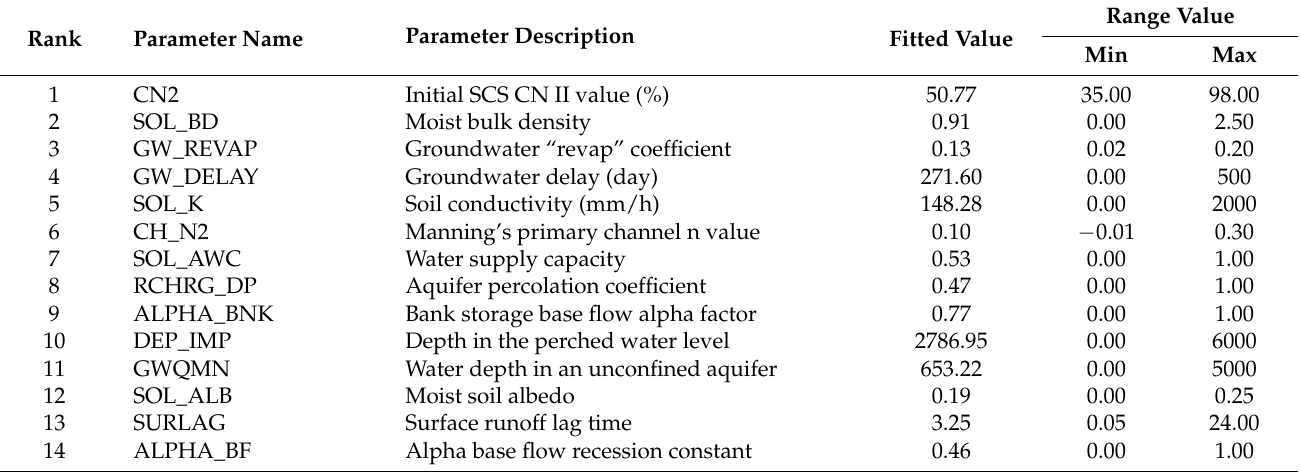
Table 3. The flow-sensitive parameters and their acceptable values.